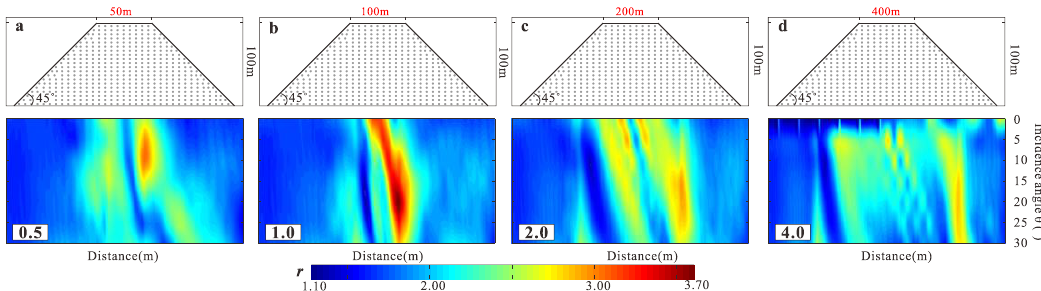
Figure 21. Variations of the seismic responses along the slope ridges and slope crests of the real amplification ratios ( r ) of PGA with varied angles of wave incidence at different slope widths, ( a ) slope width of 50 m, ( b ) slope width of 100 m, ( c ) slope width of 200 m ( d ) slope width of 400 m